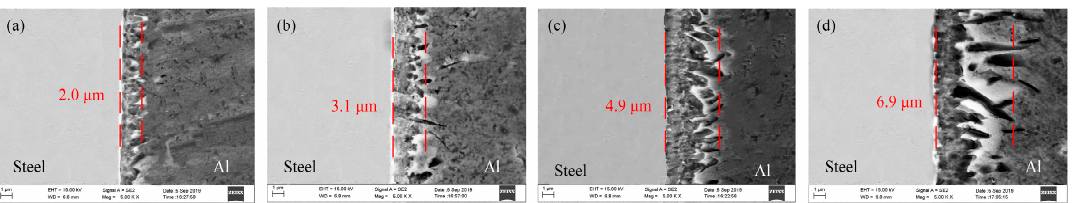
Figure 10. Microstructure of the IMCs layer with different wire feeding speed: ( a ) 4.0 m/min; ( b ) 4.5 m/min; ( c ) 5.0 m/min.